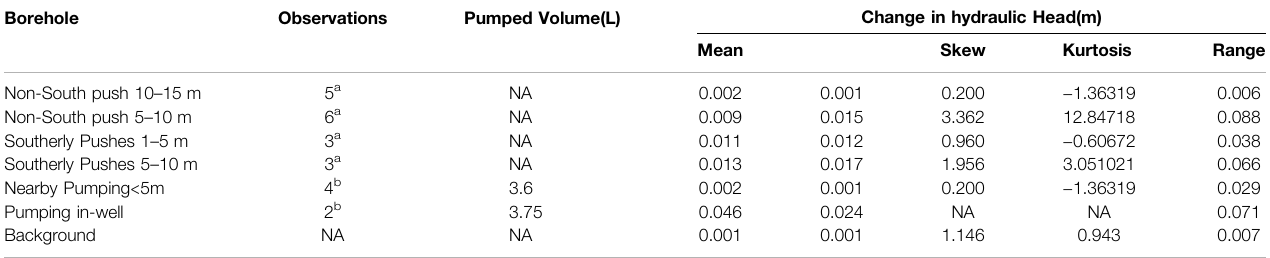
TABLE 2 | Change in hydraulic head based on distance and orientation from FW112.